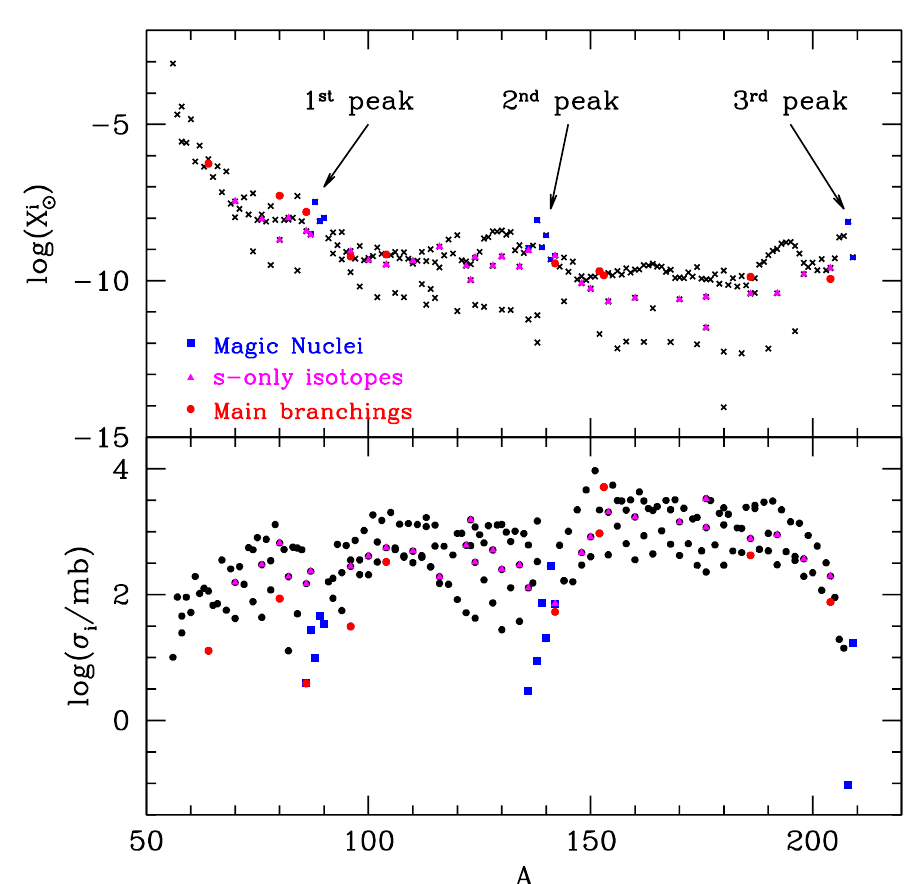
Figure 1. Upper panel : isotopic solar distribution (mass fractions); lower panel : isotope neutron capture cross sections (in mb). In each panel, isotopes of interest are magnified (see text for details). The three abundance peaks produced by the s process are highlighted ( upper panel